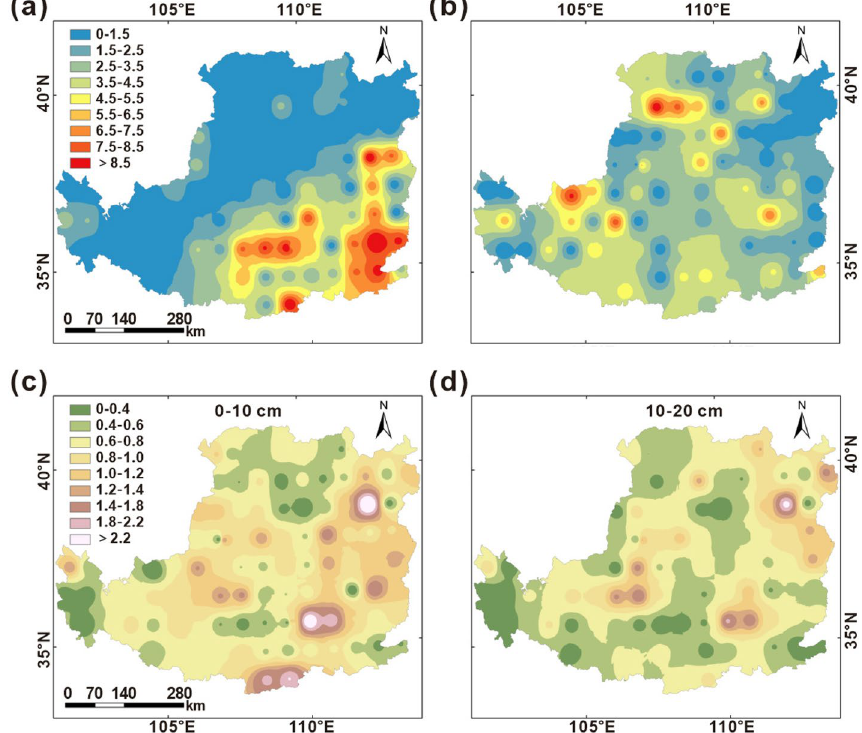
Fig. 3 Spatial distribution of above-ground carbon density (AGCD) ( a ), below-ground carbon density (BGCD) ( b ), soil organic carbon density (SOCD) in 0–10 cm layer ( c ), and soil organic carbon density (SOCD) in 10–20 cm layer ( d ) across the Loess